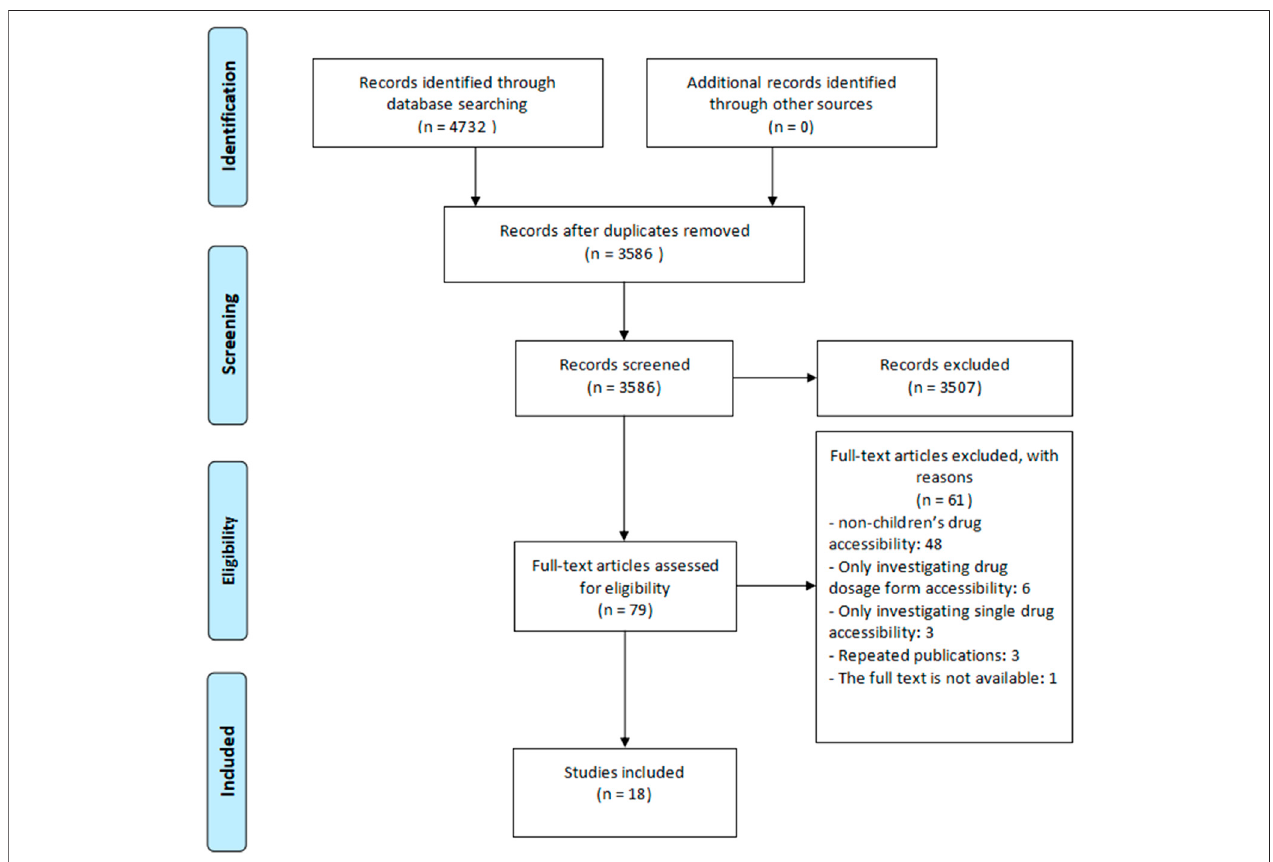
FIGURE 1 | Flow diagram of the study selection